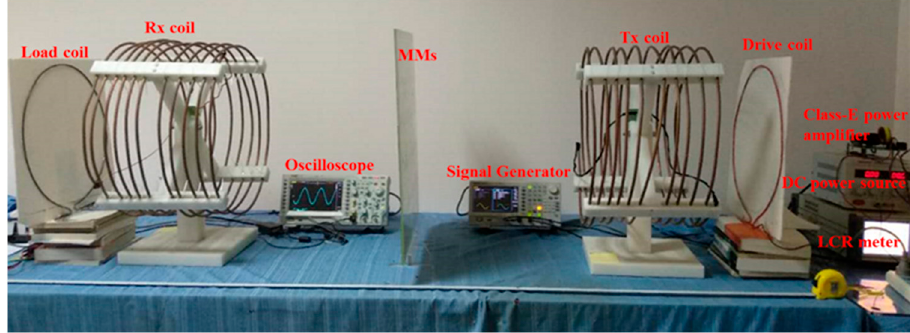
( b ) Figure 10. ( a ) The physical circuit board of each component of the Class ‐ E amplifier. ( b ) The voltage waveform of the test load resistance. To verify the proposed the method, a four ‐ coil WPT system with the MMs was built, as shown in Figure 11. The radius of the Tx coil was set to 25 cm, a turn of 10, and a pitch of 4 cm, with the